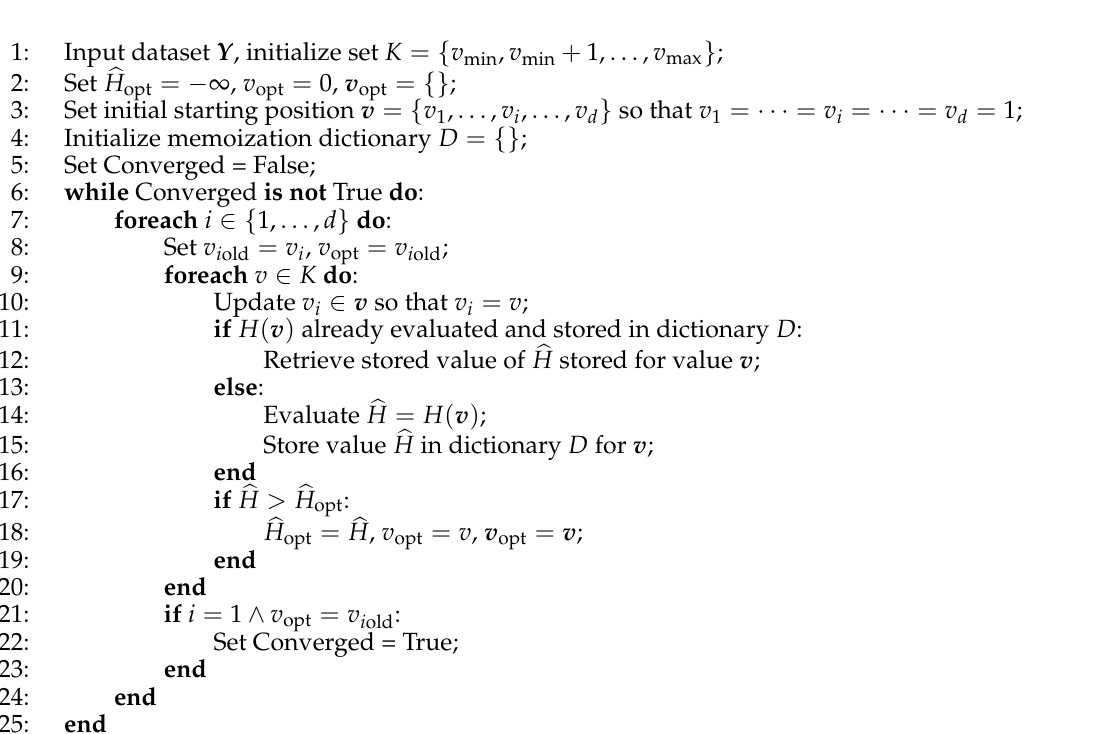
Algorithm 7: Coordinate-descent algorithm for optimum histogram binning v with